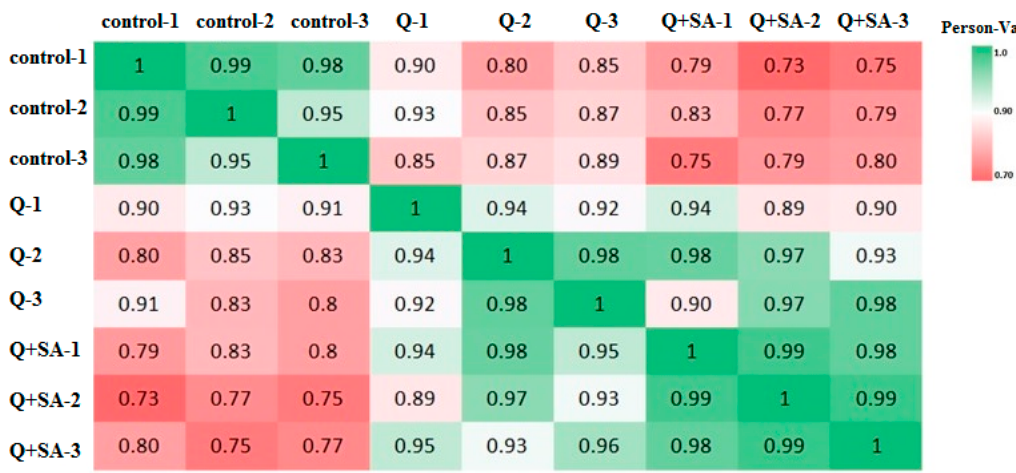
Figure 1. Correlation heatmap of samples. The gradient color barcode at the top-right indicates the minimum value in red and the maximum in green. If one sample is highly similar to another one, the correlation value between them is very close to 1.